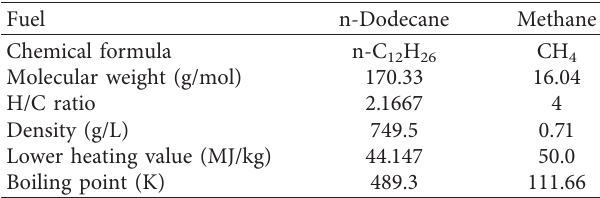
Table 1: Selected fuel